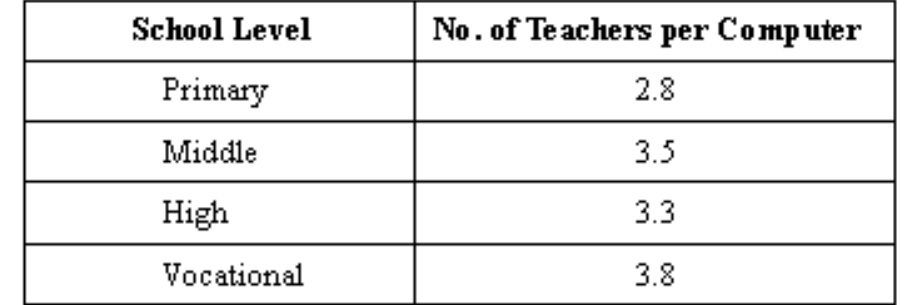
Table 2: Number of Teachers per Computer